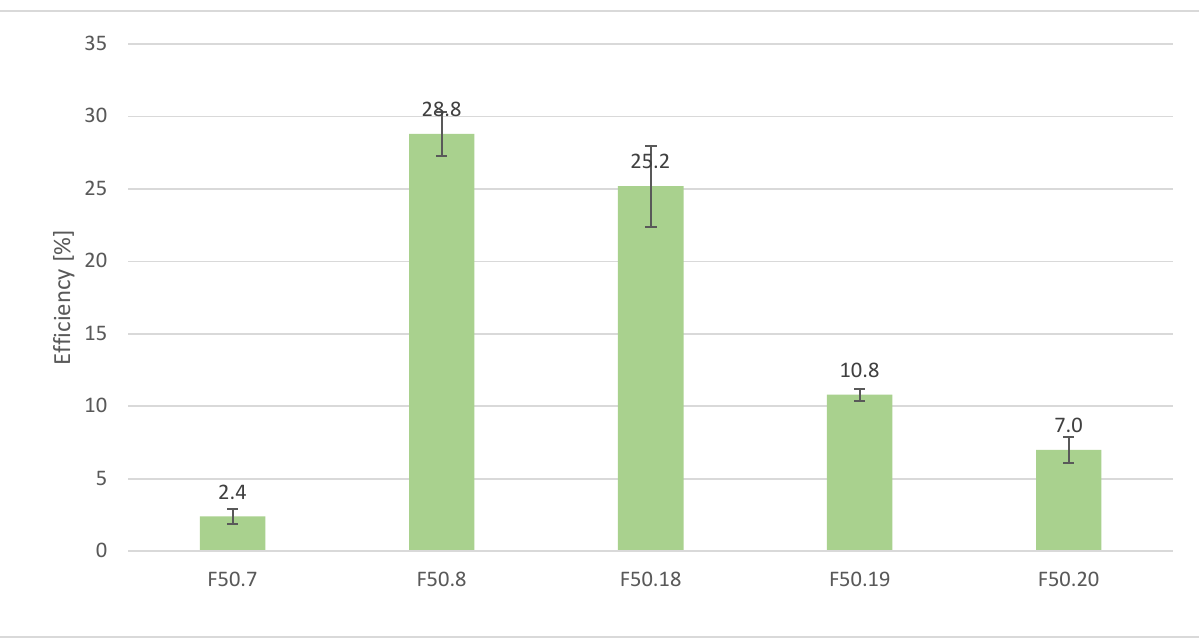
Figure 6. The efficiency of the formulations F50.7 (Mg(OH) 2 = 130; PCC = 0), F50.8 (Mg(OH) 2 = 40; PCC = 90), F50.18 (Mg(OH) 2 = 30; PCC = 100), F50.19 (Mg(OH) 2 = 90; PCC = 40), F50.20 (Mg(OH) 2 = 100; PCC = 30) . Standard deviation ranges are reported.